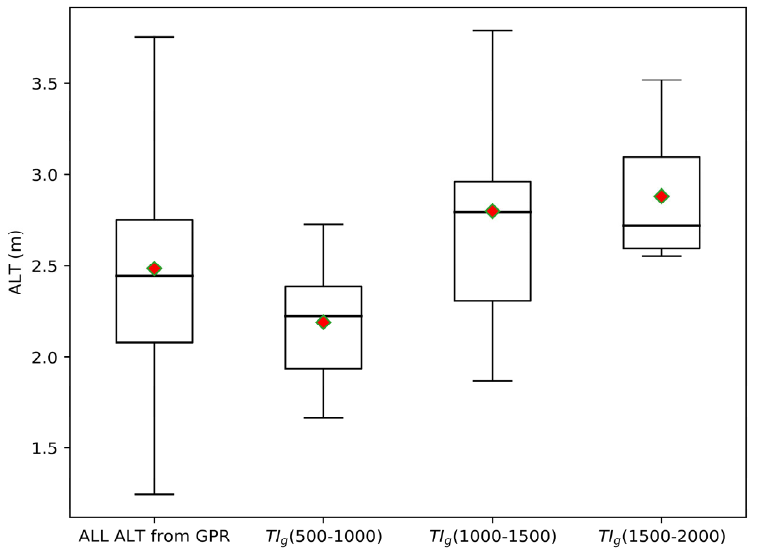
Figure 8. Active layer thickness (ALT) for all the measurements and groups with different ranges of ground thawing index ( TI g ).